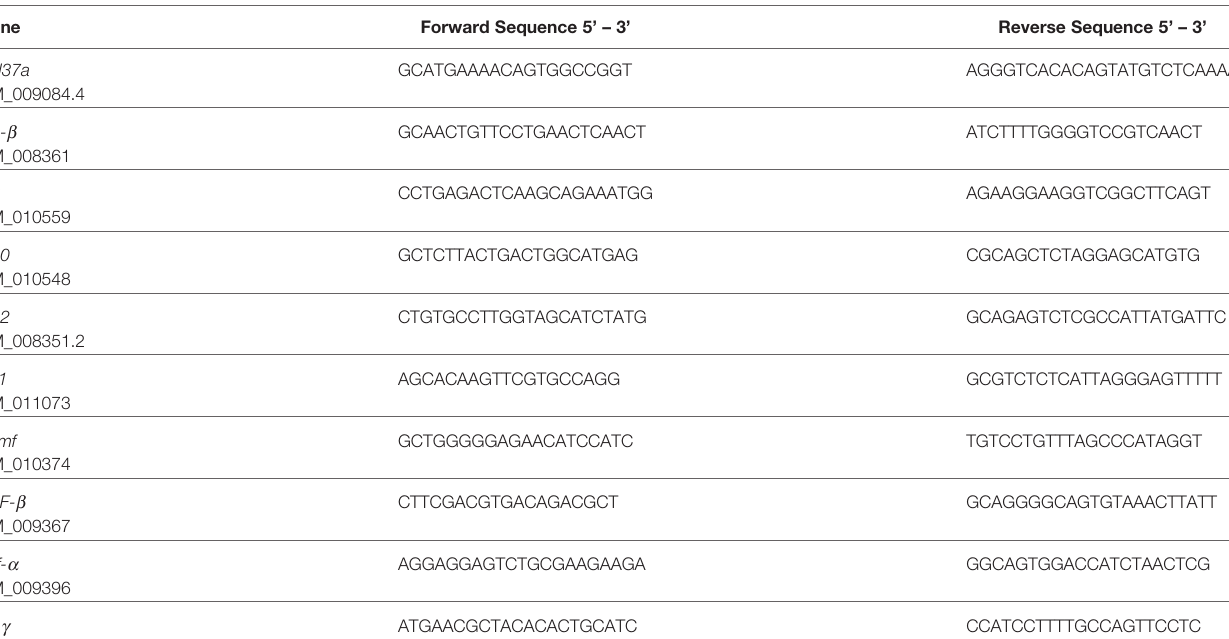
TABLE 1 | List of primers used (300 nM) in the manuscript, and the corresponding access numbers.